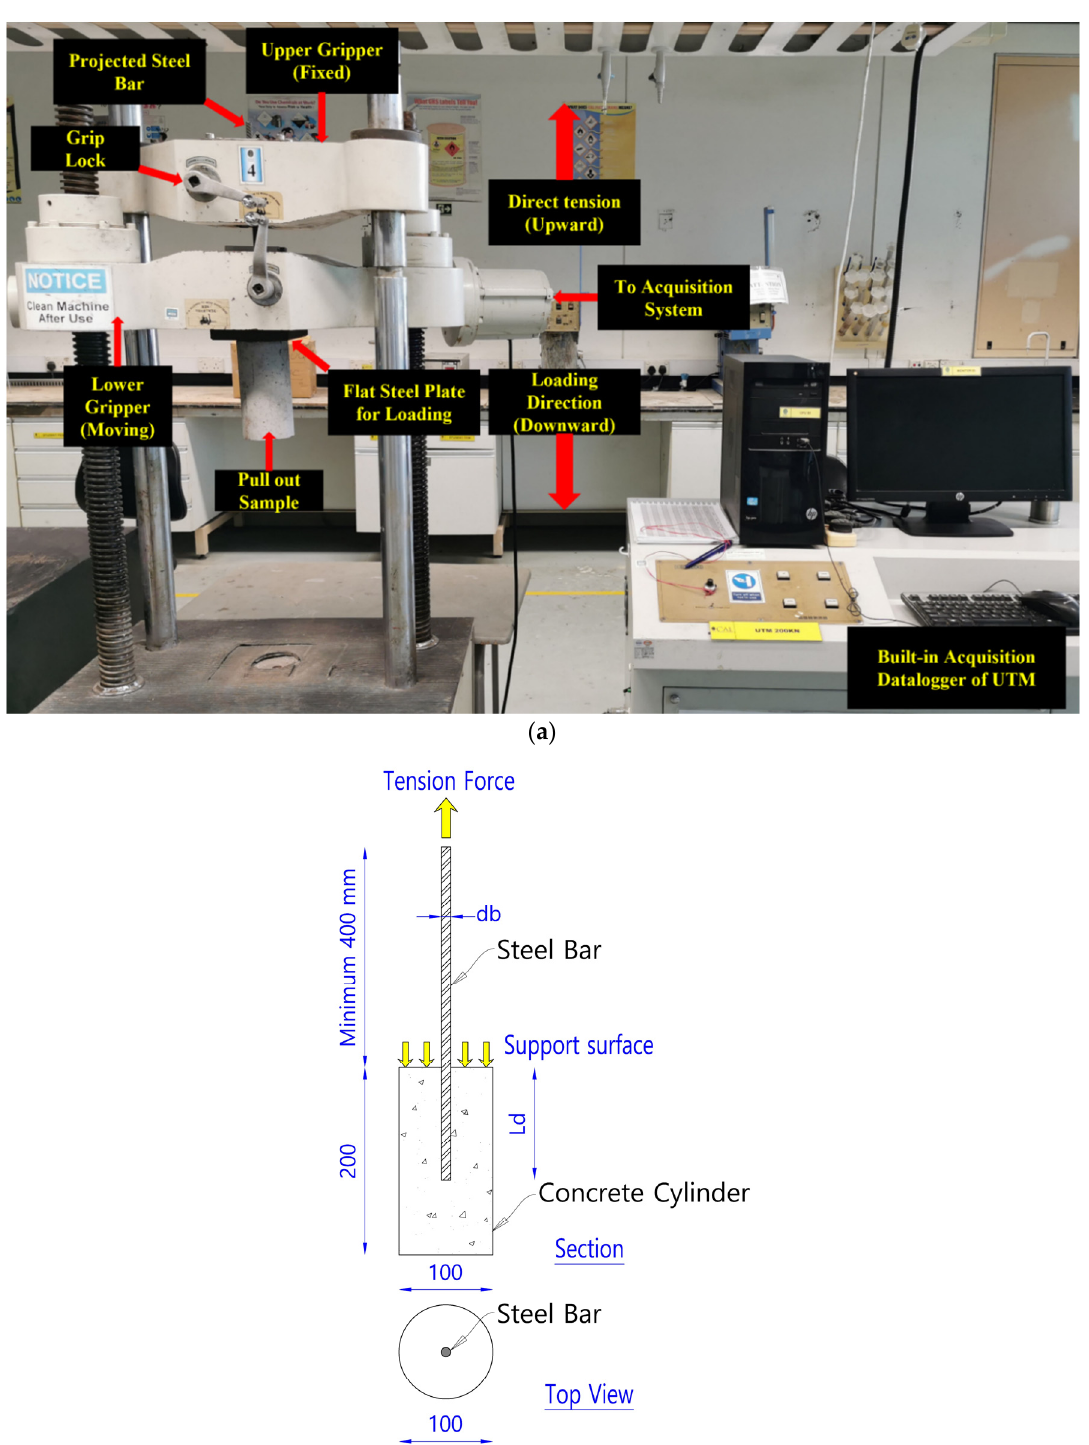
Figure 6. Test setup and specimen geometry: ( a ) the setup for the direct tension pullout test; ( b ) test direction, and specimen geometry.